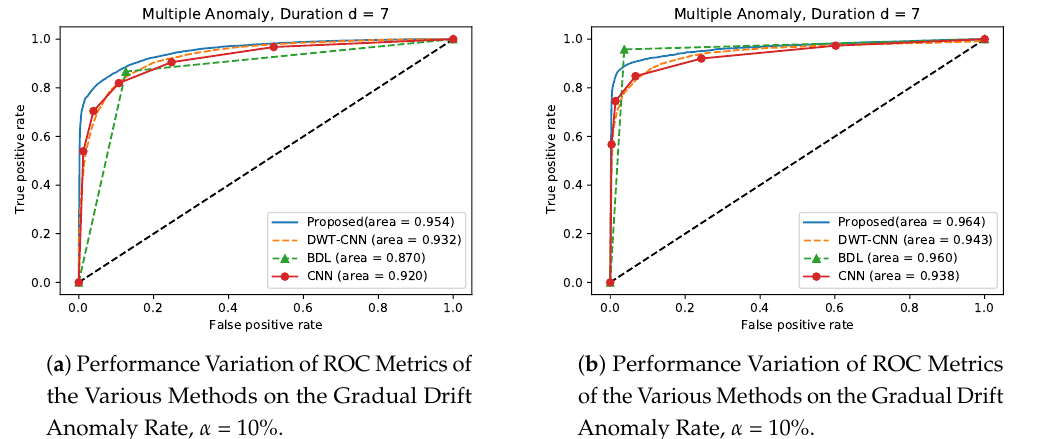
Figure 15. Performance Variation of the Various Methods trained on Bias Anomaly , on Gradual Drift Anomaly at α = 50% and α =